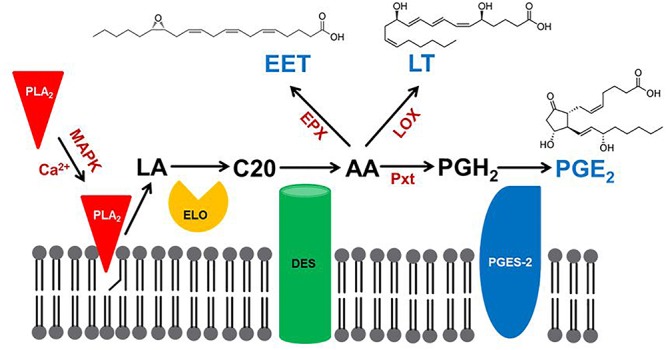
A model for eicosanoid biosynthesis in insects. PLA2 activated by calcium or mitogen-activating protein kinase (MAPK) catalyzes the hydrolysis of linoleic acid (LA), which is extended in chain length to C20 fatty acid by a specific elongase (ELO). The C20 precursor is oxidized by desaturases (DES) to produce arachidonic acid (AA; Stanley-Samuelson et al., 1988), which is oxygenated by epoxidase (EPX) to produce epoxyeicosatrienoic acid (EET), by lipoxygenase (LOX) to produce leukotriene (LT) or by a specific peroxinectin (Pxt) to produce prostaglandin H2 (PGH2). PGH2 is then isomerized by PGE2 synthase-2 (PGES-2) to PGE2.